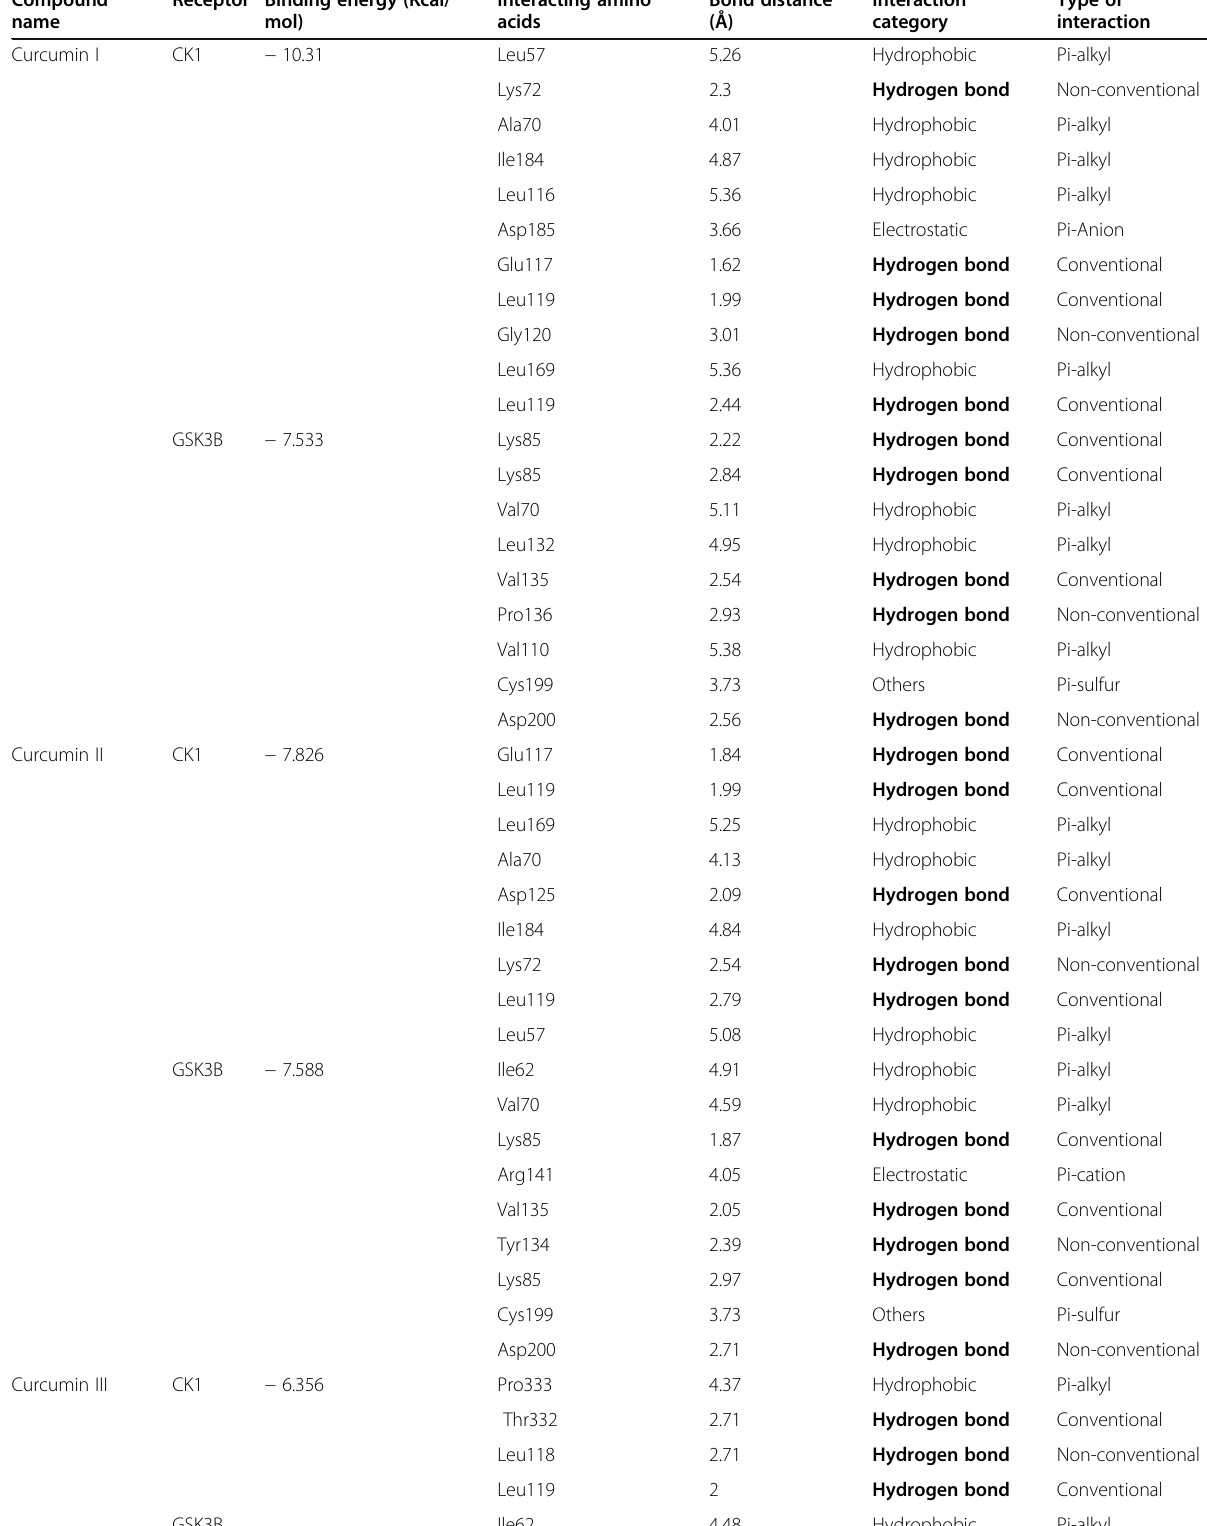
Table 1 Result of molecular docking between curcumin I (PubChem CID: 969516), curcumin II (PubChem CID: 5469424), curcumin III (PubChem CID: 5315472), and CK-1 (PDB Id: 2IZS) and GSK3B (PDB Id: